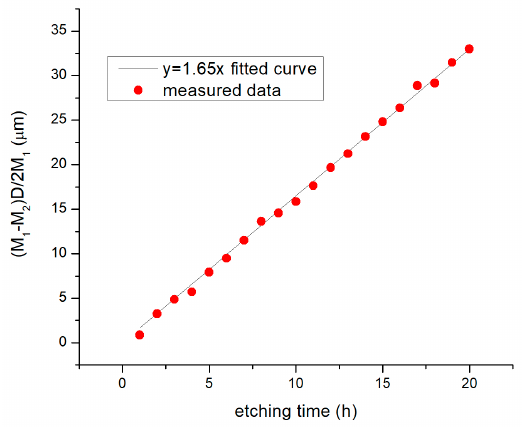
Figure 2. Experimental (red points) and theoretical (black line curve) CR-39 detectors thickness evolution as a function of the etching time.